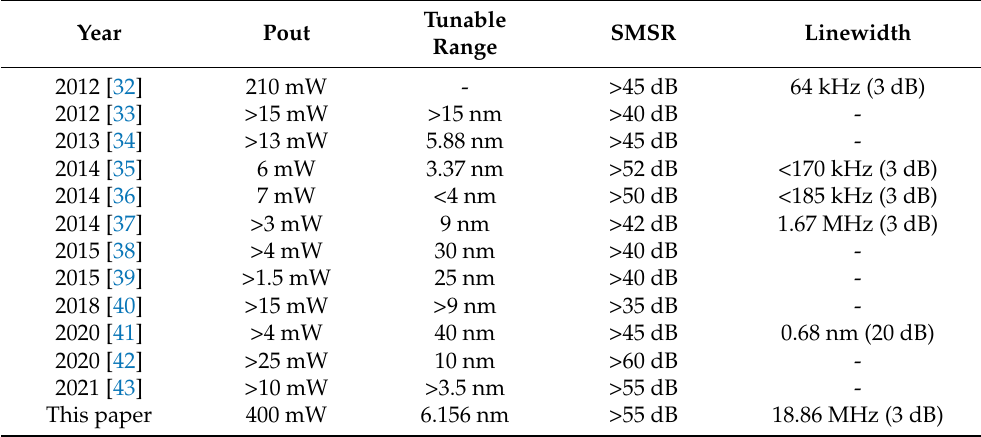
Table 1. The parameters of the device in this paper are compared with other reported DFB lasers.